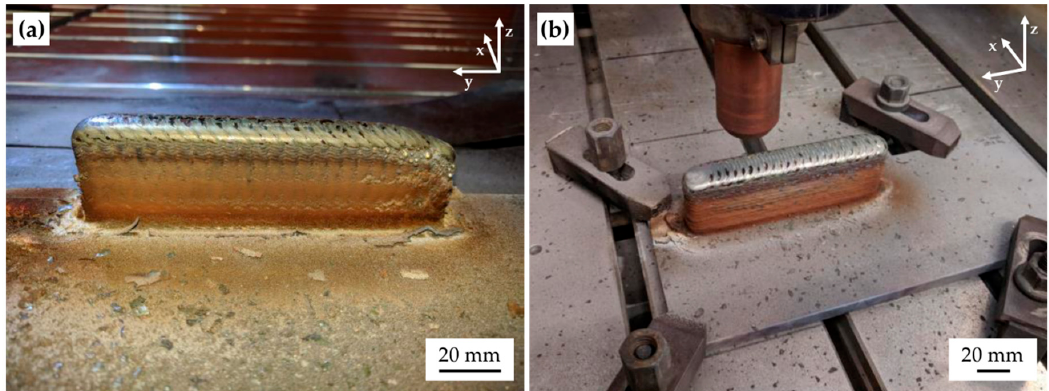
Figure 3. Images of the fabricated walls. ( a ) W1, produced in air atmosphere; ( b ) W2, produced in argon protective atmosphere.